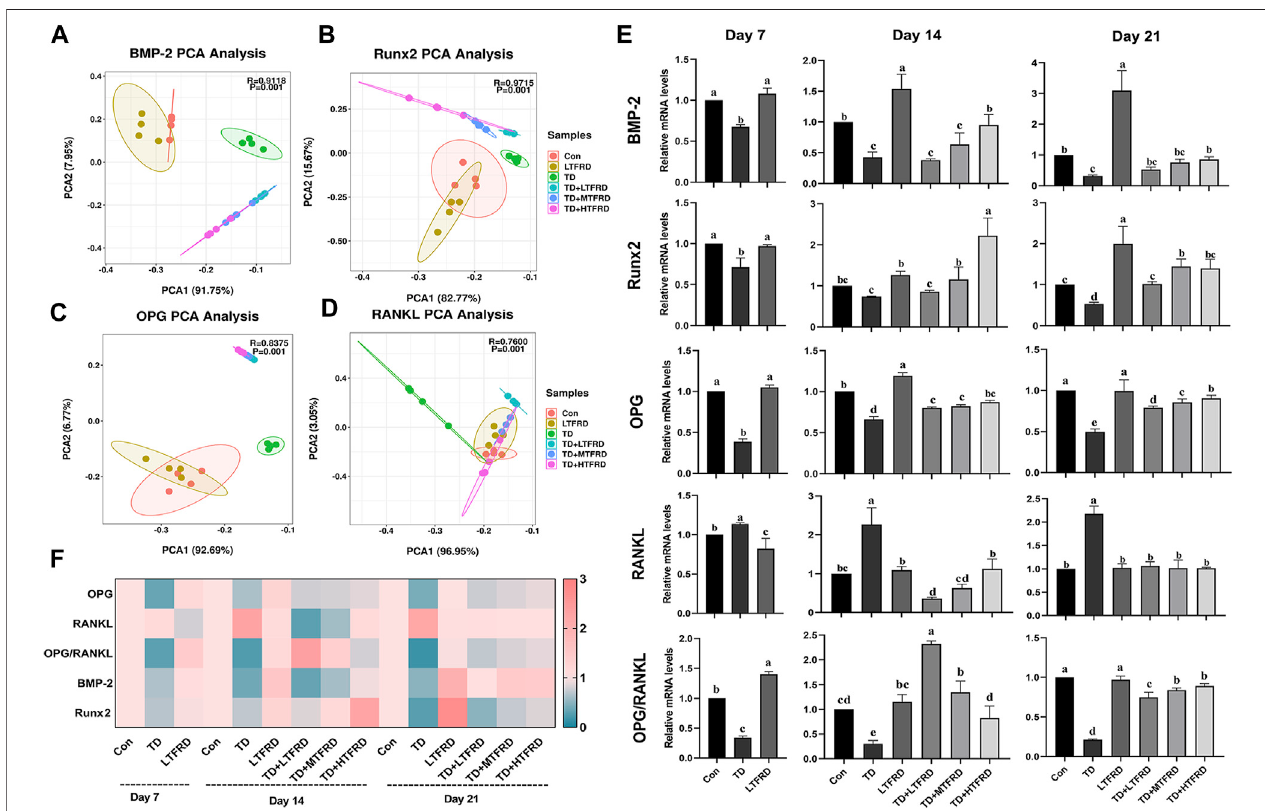
FIGURE 4 | Effects of TFRD on gene expression levels of BMP-2/Runx2 and OPG/RANKL in tibial growth plate in TD broilers. (A – D) Principal component analysis (PCA) of the BMP-2 , Runx2 , OPG and RANKL gene expressions with an unsupervised pattern recognition method. (E) The mRNA expression of genes BMP-2 , Runx2 , OPG , RANKL and the ratio of OPG/RANKL at day 7, 14 and 21. (F) The heat map shows the mRNA levels of the bone-related genes. The results are represented as mean ± SD. a, b, c, and d represent signi fi cant differences between groups ( p < 0.05).